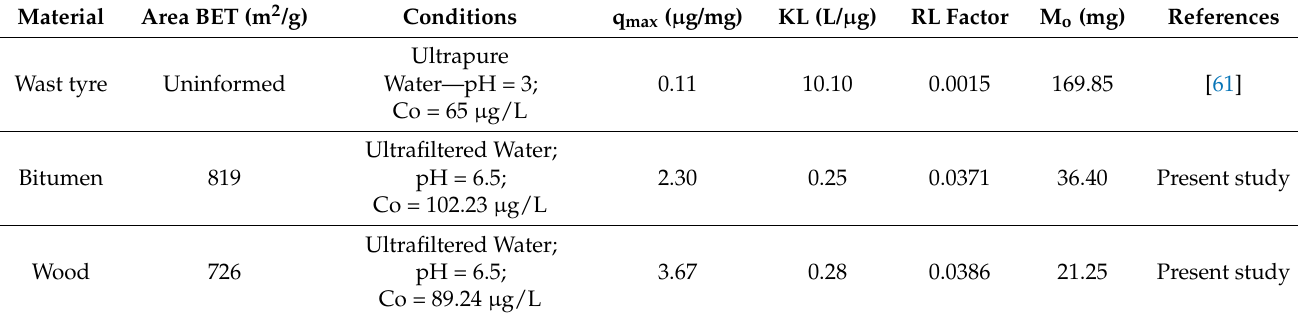
Table 6. Langmuir parameters for CYN removal in activated carbon—Bibliographic